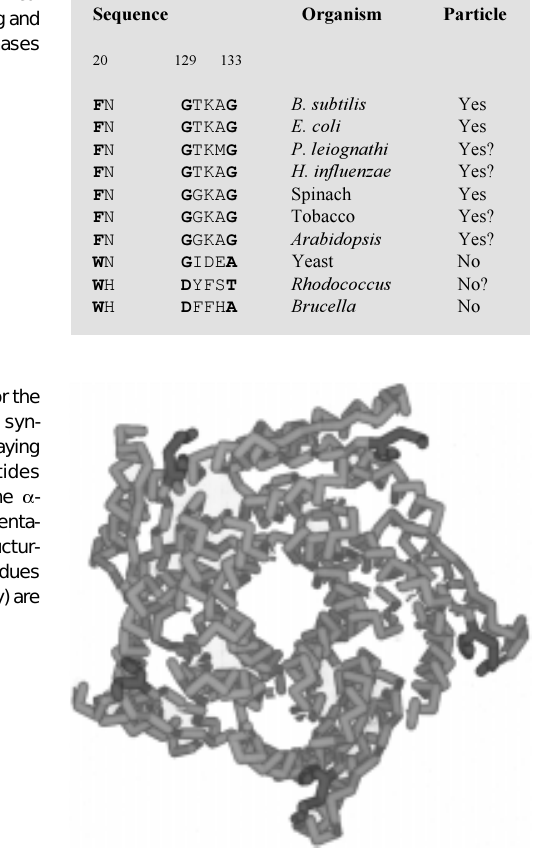
shown.Figure 3 - Conservation of critical residues for capside-forming and pentameric lumazine synthases from different